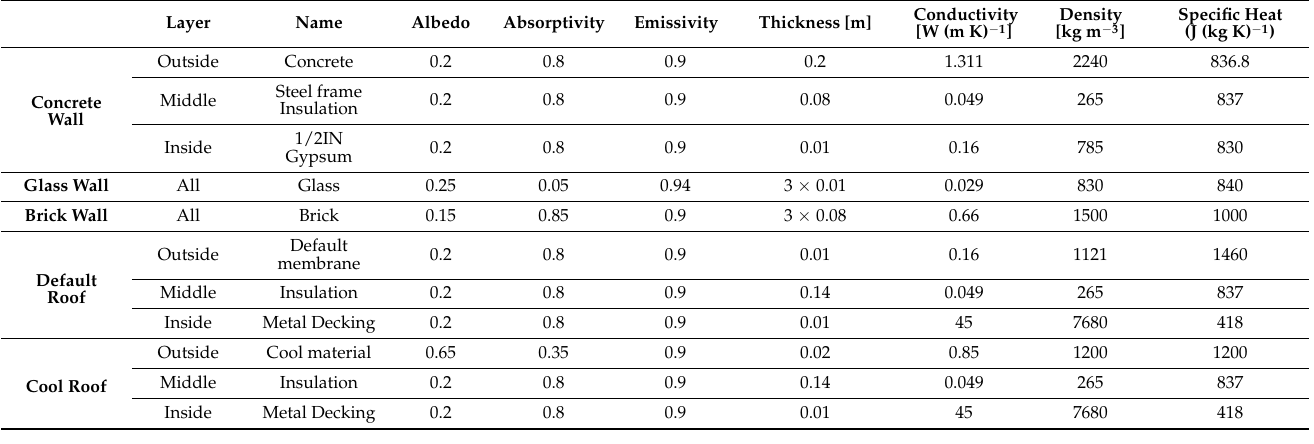
Table 1. Summary of material properties in the proof-of-concept simulation [51].